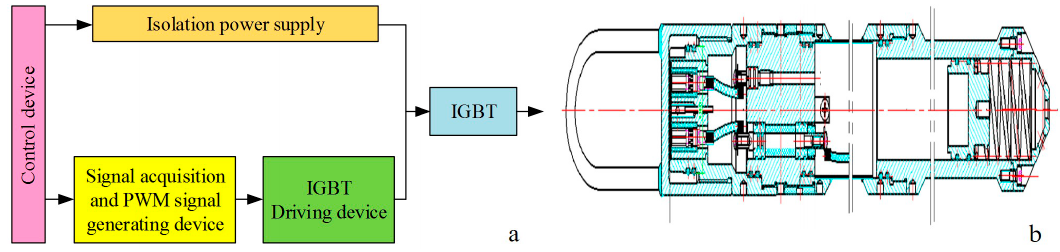
Figure 3. High-power ultrasonic equipment: ( a ) a 160 kW ultrasonic generator structure diagram; and ( b ) a 10 kW ultrasonic transducer.